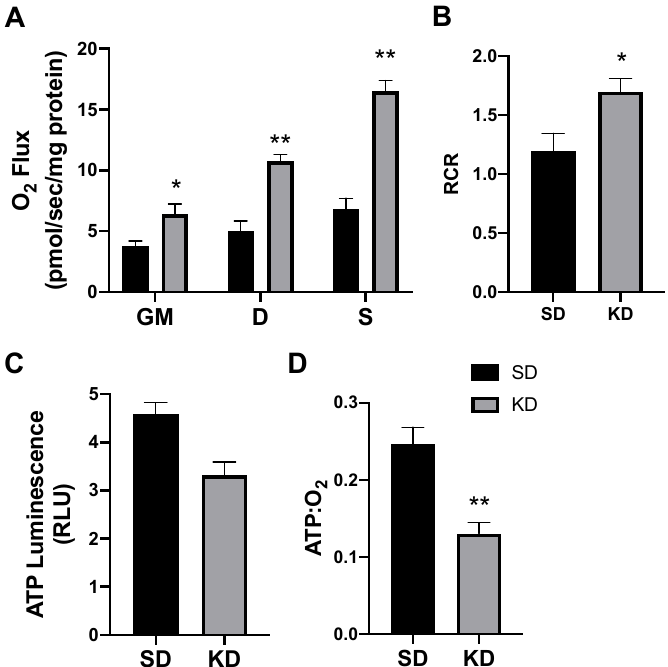
Figure 5. A ketogenic diet alters rodent subcutaneous inguinal adipose mitochondrial bioenergetics. Following the 28-day intervention of either ketogenic diet (KD) or standard diet (SD), the inguinal adipose was harvested and permeabilized to measure the mitochondrial respiration ( A ) and respiratory control ratio (RCR; B ). ATP was measured via luminescence from fresh tissue ( C ), and the ratio of ATP and oxygen respiration was quantified ( D ). n = 6. * p < 0.05. ** p < 0.01.